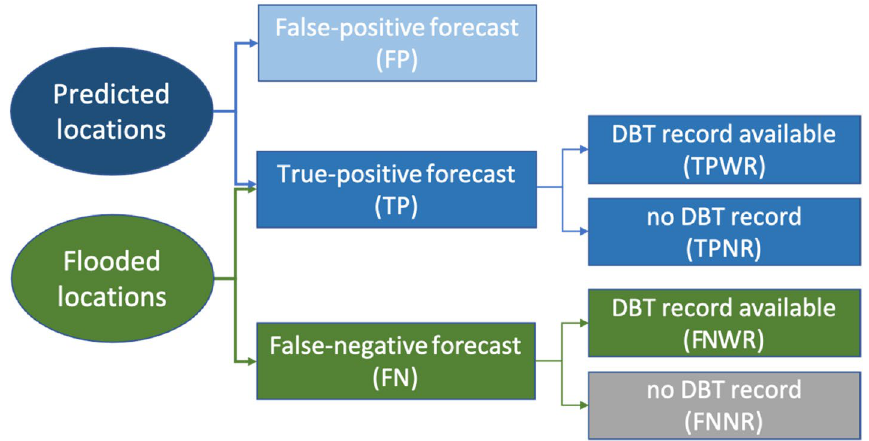
Figure 2. Classification of flood locations related to Typhoon Hagibis. This figure was generated through Microsoft PowerPoint Version 16.47 provided by University of